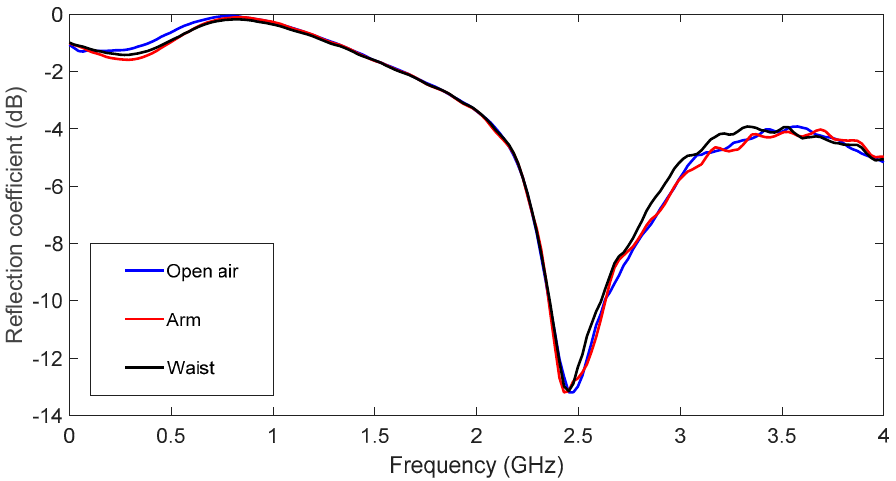
Figure 13. Reflection coefficient measured in the air and on the body.